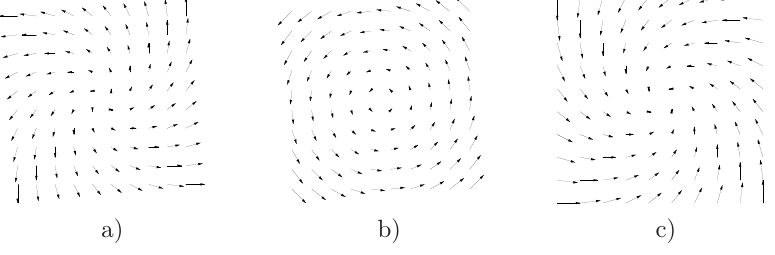
Figure 3. The general view of the vector field ξ = ( bx − ay,ax + by ) for various values of the parameter α = (0 . 5 , 1 , 1 . 5) for the corresponding a), b) and c)